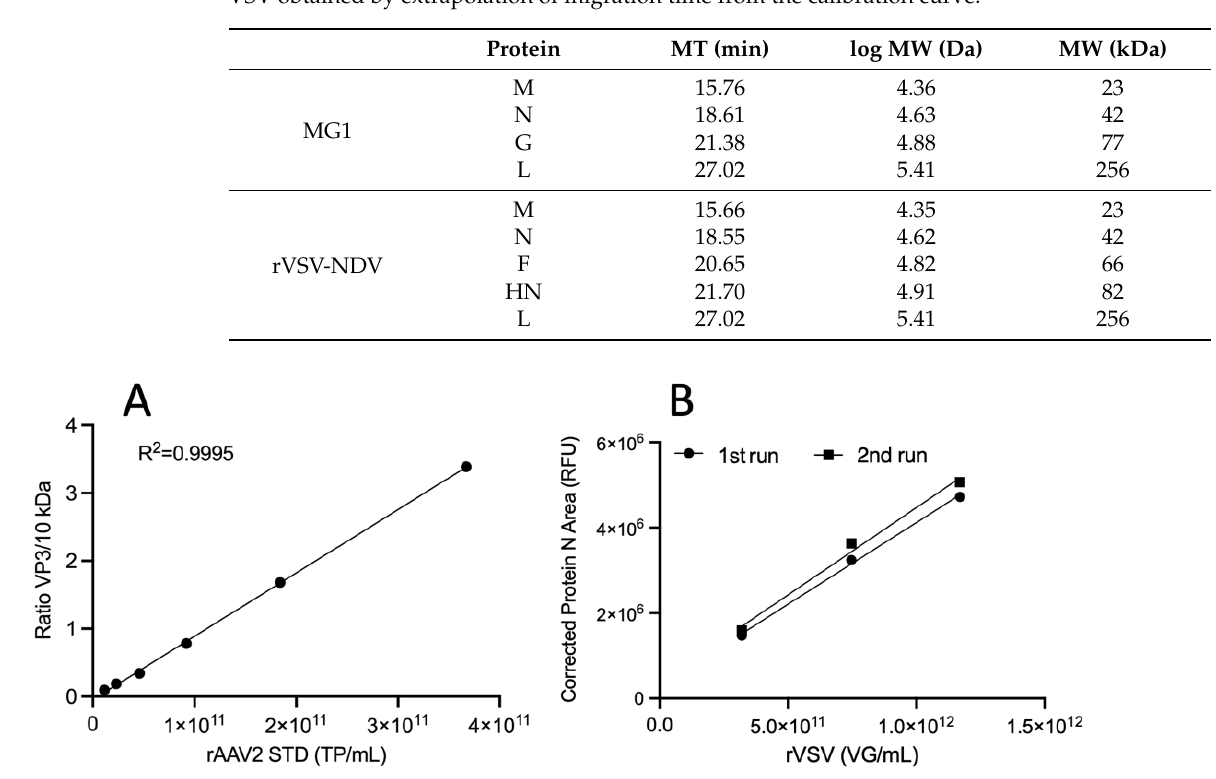
Figure A3. Representative chromatogram of LV purification using anion exchange chromatography (AEX) with step elution. (A) Washing step. (B) Low Ionic Strength Step Elution. (C) High Ionic Strength Step Elution. Table A2. CE-SDS LIF method qualification for quantification of AAV using a Reference standard AAV2 sample; LODs and LOQs and their average estimation are shown. LODs and LOQs were calculated based on signal to noise ratio methodology for each experiment. Replicates 1